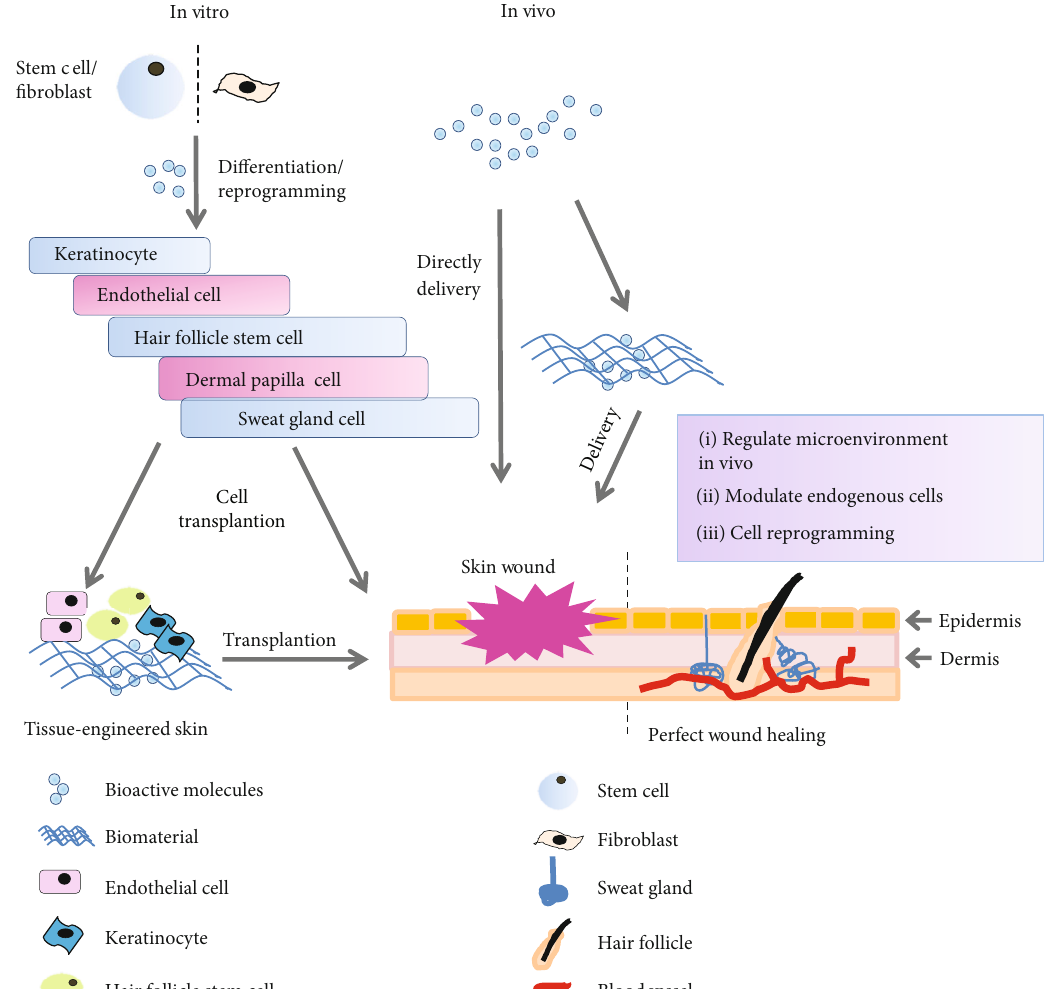
Figure 1: The strategies of skin regeneration using bioactive molecules. The repairing of cells induced from stem cells or somatic cells by using bioactive molecules in vitro for skin repair or stimulating skin endogenous cells to regenerate skin in vivo by using bioactive molecules as a conventional